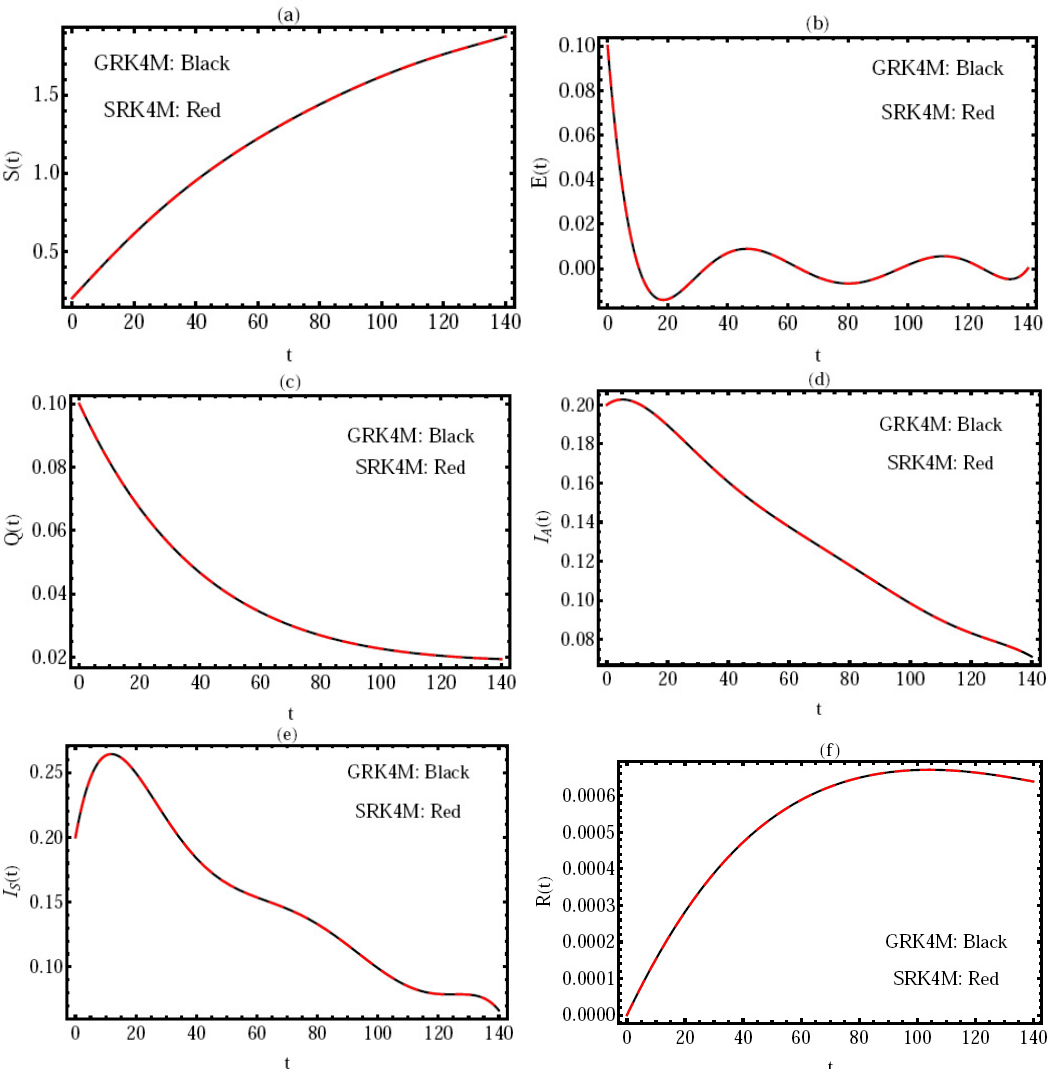
Figure 2. The solution by GRK4M and SRK4M at α = 1 ( a – f